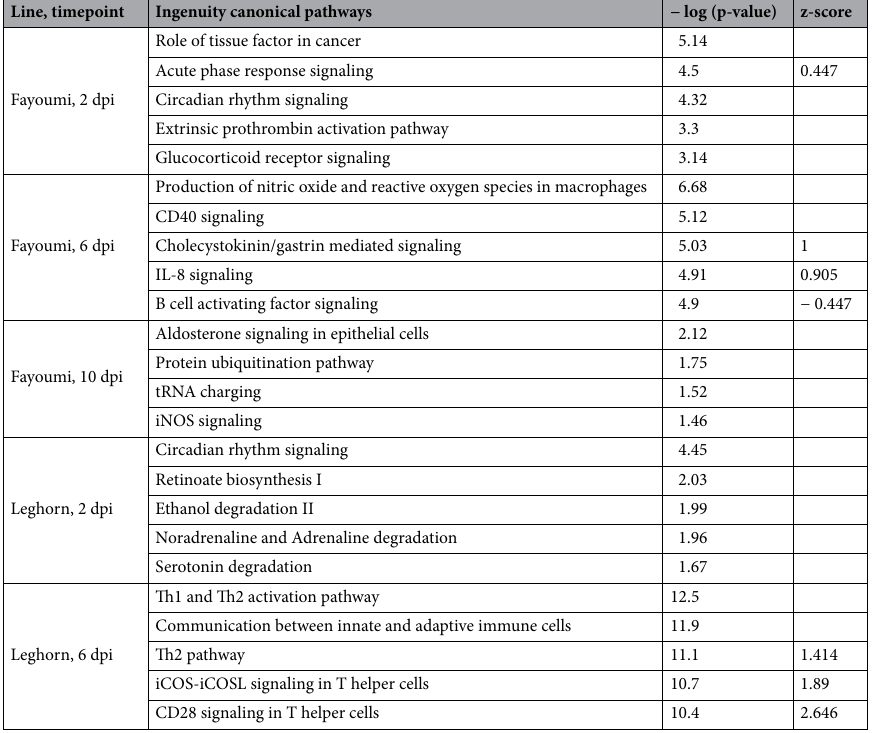
Table 2. Top five most significant canonical pathways identified by ingenuity pathway analysis among differentially expressed genes from within line comparisons by timepoint. Z-score > 0 indicates a pathway predicted to be activated, and Z-score < 0 predicts the pathway to be inhibited. No value listed indicates the analysis was unable to predict pathway